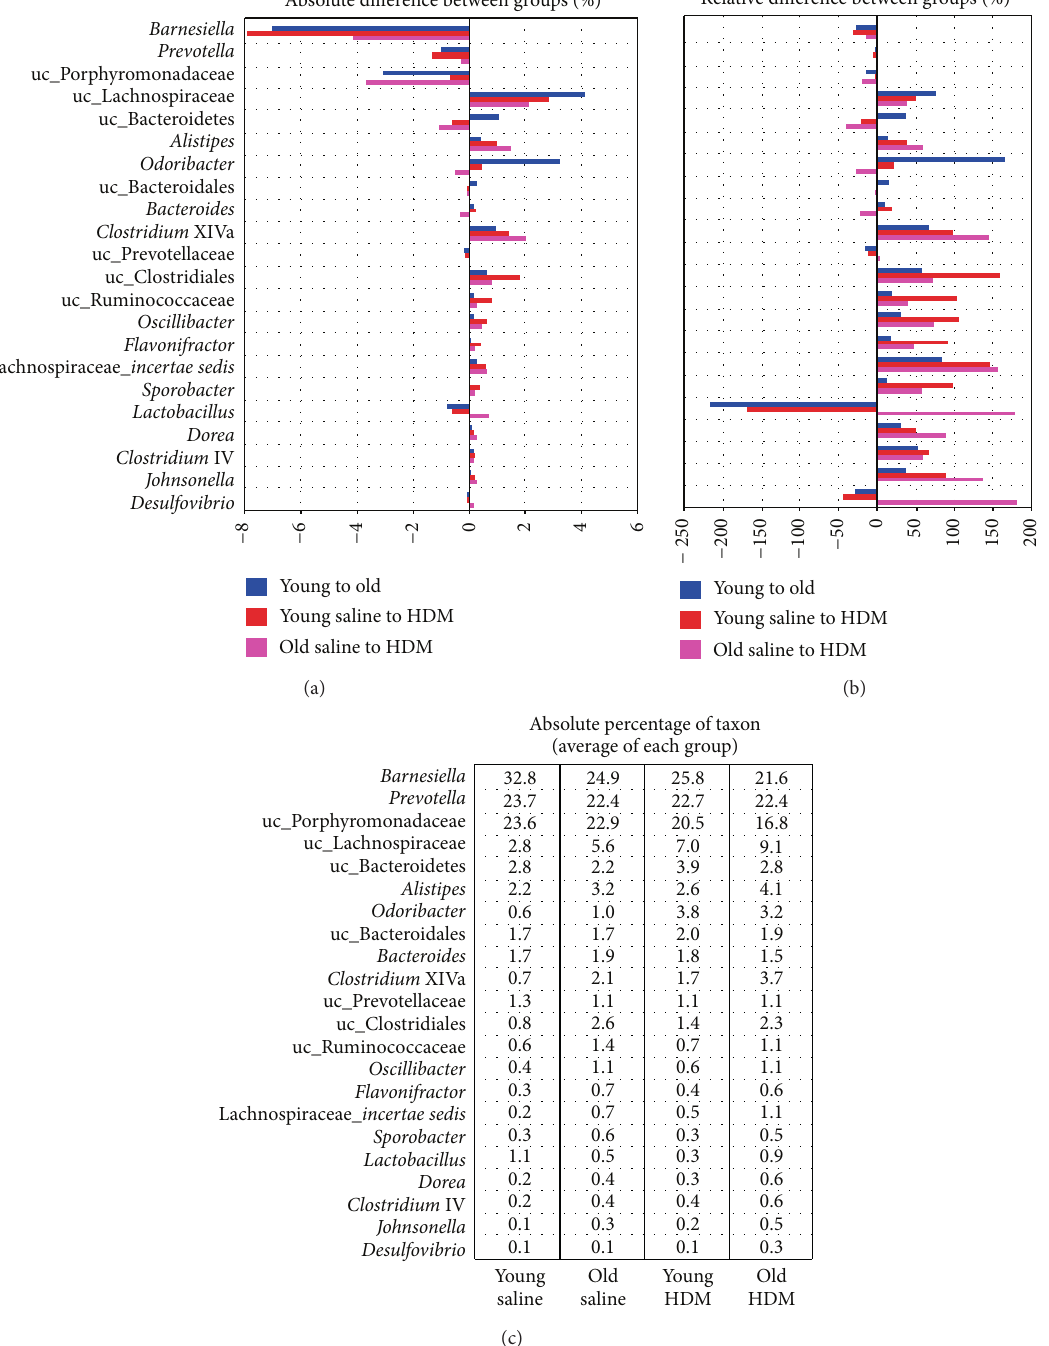
Figure 5: Details on community structure differences between groups. (a) shows the absolute difference of genera between groups (in %), whereas relative differences are given in figure (b). Relative abundances of taxa within groups are displayed in figure (c). Only taxa that comprised at least 1% of the total community in any sample are shown. uc: